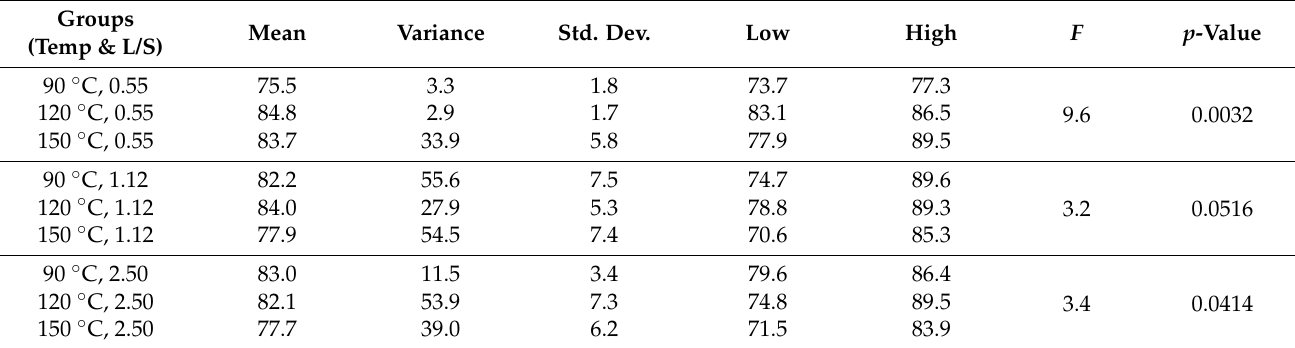
Figure 1. Effect of temperature on compositions of ELLA-treated corn stover. Treatment conditions: ( a ) ELLA treatment: L/S = 0.55, 90 ◦ C, 0.08 g-NH 3 /g-biomass; ( b ) ELLA treatment: L/S = 0.55, 120 ◦ C, 0.1 g-NH 3 /g-biomass; and ( c ) ELLA treatment: L/S = 0.55, 150 ◦ C, 0.1 g-NH 3 /g-biomass; ASL (acid soluble lignin) and AIL (acid insoluble lignin). Table 2. ANOVA results of glucan digestibility at different pretreatment temperatures.